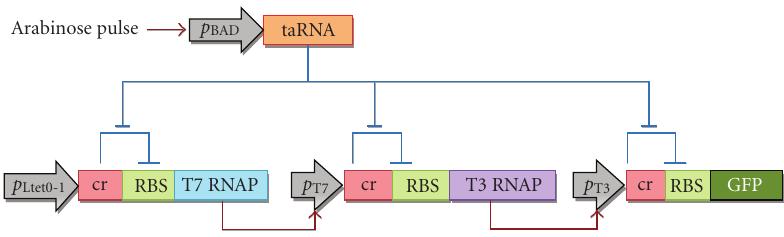
Figure 5: Design concepts for the RTC three-counter in Friedland et al. [7]. To count three induction events, the RTC three-counter employs a transcriptional cascade that has three nodes. The constitutive promoter p Ltet0-1 drives transcription of T7 RNA polymerase (T7 RNAP), whose gene product binds the T7 promoter, which in turn controls the transcription of T3 RNAP. Similarly the protein of T3 RNAP binds the T3 promoter and ultimately controls the transcription of GFP. All genes are further downregulated and upregulated by cis and trans elements of riboregulators. A cis repressor (cr) interacts with the downstream ribosome binding site (RBS) in such a manner as to prevent translation. The arabinose promoter p BAD drives a transactivating, noncoding RNA (taRNA) that binds to cr in trans, thus relieving this inhibition of translation. Due to this design, protein synthesis at each node requires both transcription and translation to independently happen. Thus this cascade is able to count three arabinose pulses by expressing a di ff erent protein in response to each pulse (adapted from Friedland et al. [7]).